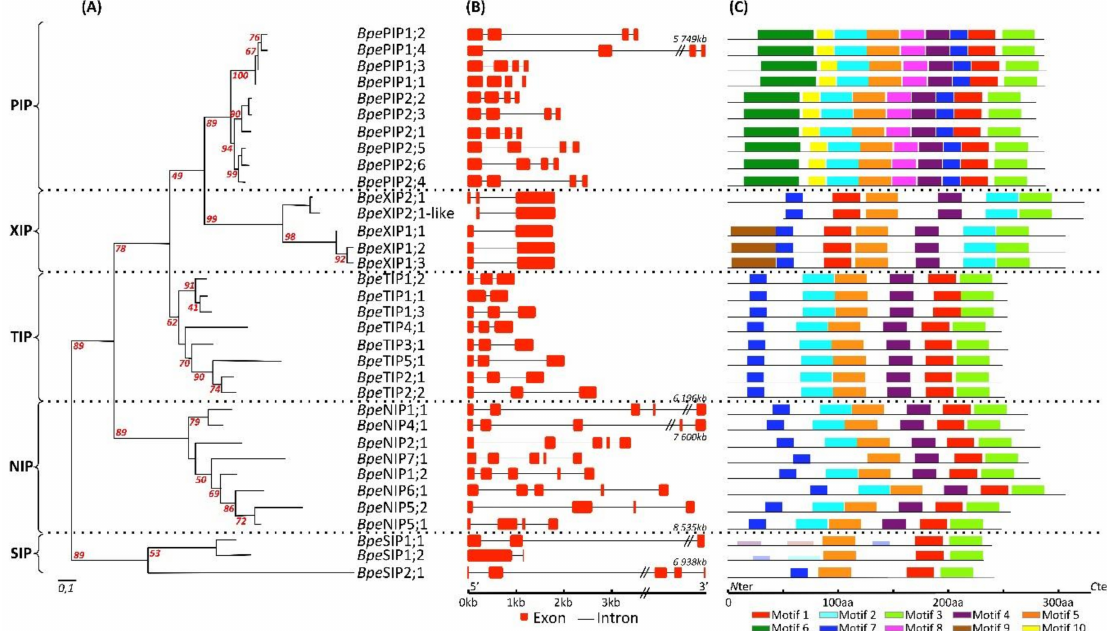
Figure 2. ( A ) Phylogenetic relationship, ( B ) Exon/Intron genomic structure, and ( C ) Protein motif organization of the 33 full-length and the pseudogene Bpe XIP2;1-like Betula pendula aquaporin sequences. ( A ) Deduced amino acid sequences were aligned using ClustalW, and the phylogenetic tree was constructed using the maximum parsimony method. Maximum parsimony analysis was conducted using the subtree-pruning-regrafting algorithm. The number next to the branch’s nodes represents bootstrap values ≥ 50% based on 5000 resamples. Bpe AQPs clustered into five AQP subfamilies: Bpe PIPs, Bpe XIPs, Bpe TIPs, Bpe NIPS and Bpe SIPs. ( B ) Exons and introns of the BpeAQP genes are represented by red boxes and black lines, respectively. Gene structures were compared using GSDS software. Gene orientations are indicated (5 (cid:48) –3 (cid:48) ) in the x -axis. ( C ) Distribution of the conserved motifs among the Bpe AQP proteins. Motif analysis was performed by using the MEME web server. Ten conserved motifs were identified, and the different motifs are identified using different colored boxes, as indicated at the bottom of the Figure. Each color block in the different proteins indicates a specific motif, for which the amino acids are detailed in Figure S3. Protein orientations are indicated ( N ter- C ter) on the x